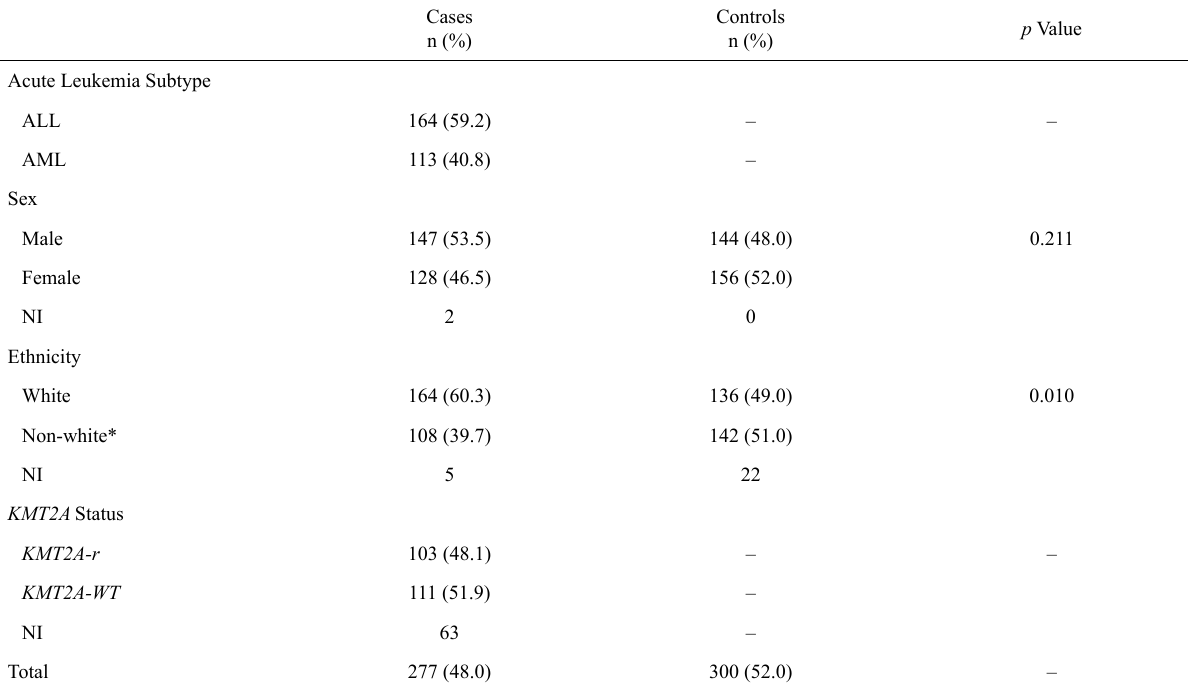
Table 1 – The frequency distribution of childhood leukemia, demography and KMT2A status, Brazil,